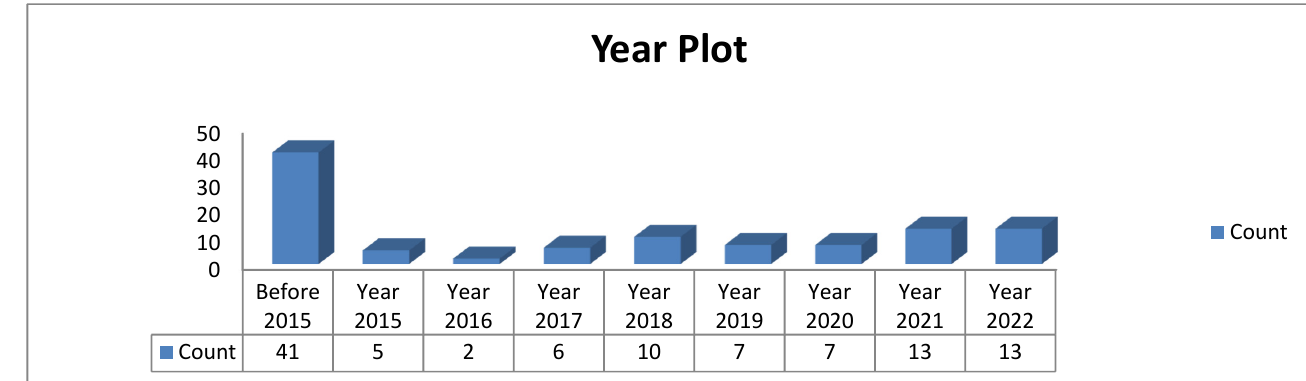
Figure 3. Year Distribution of Articles .